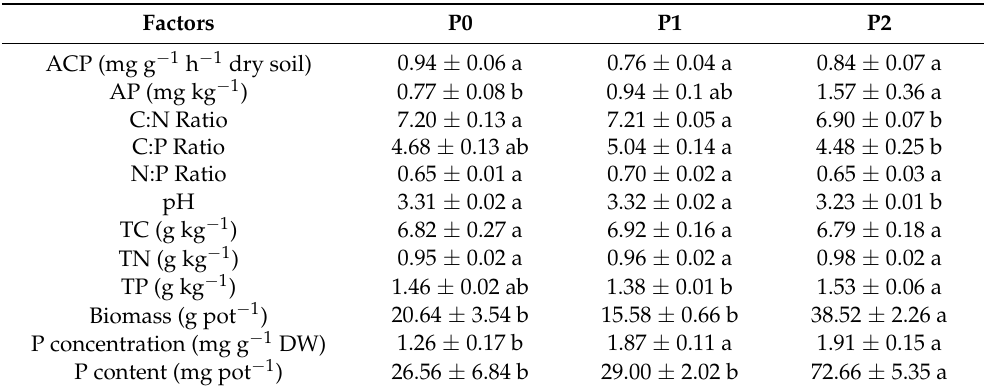
Soil environmental factors and plant traits among different treatments (mean ± standard